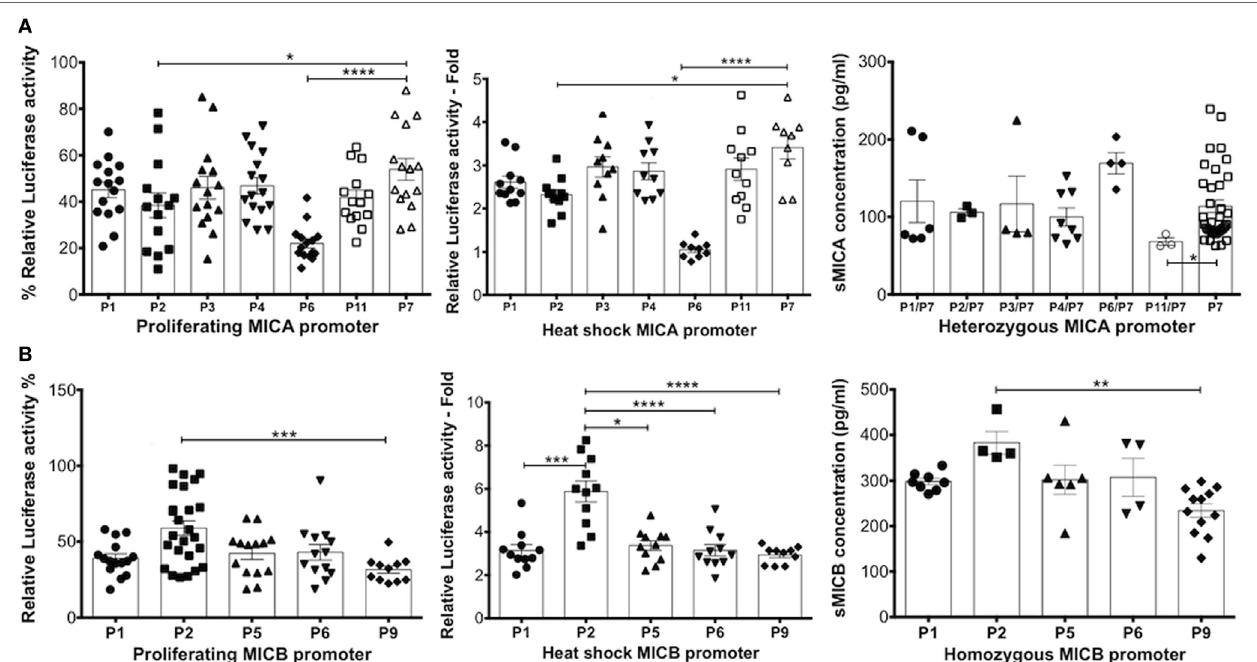
FigUre 9 | Comparison of relative luciferase transcription potential of MHC class I-related chain A (MICA)/MHC class I-related chain B (MICB) promoter types in proliferating and heat-shocked HCT116 cells and comparisons with levels of sMICA/B in cord blood. (a) Relative luciferase activity obtained using MICA promoter types. Owing to a lack of MICA homozygotes, heterozygous MICA promoter types were analysed in combination with the highly frequent MICA-P7 for comparison of sMICA levels with transcription levels. (B) Relative luciferase activity obtained using MICB promoter types associated with sMICB levels in homozygous MICB promoter typed cord blood. sMICA/B concentrations were obtained by ELISA for each cord blood plasma sample. Statistical analysis was performed using Kruskal–Wallis test with Dunn’s post hoc test ± SEM (* P ≤ 0.05, ** P < 0.01, *** P < 0.001, and **** P <